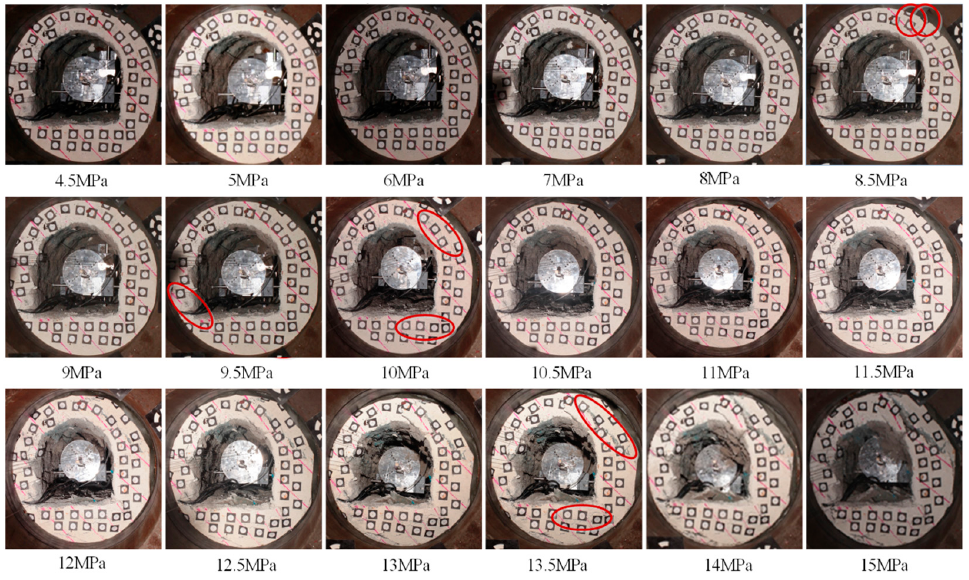
Figure 4. Roadway surface deformation from 4.5 to15 MPa.